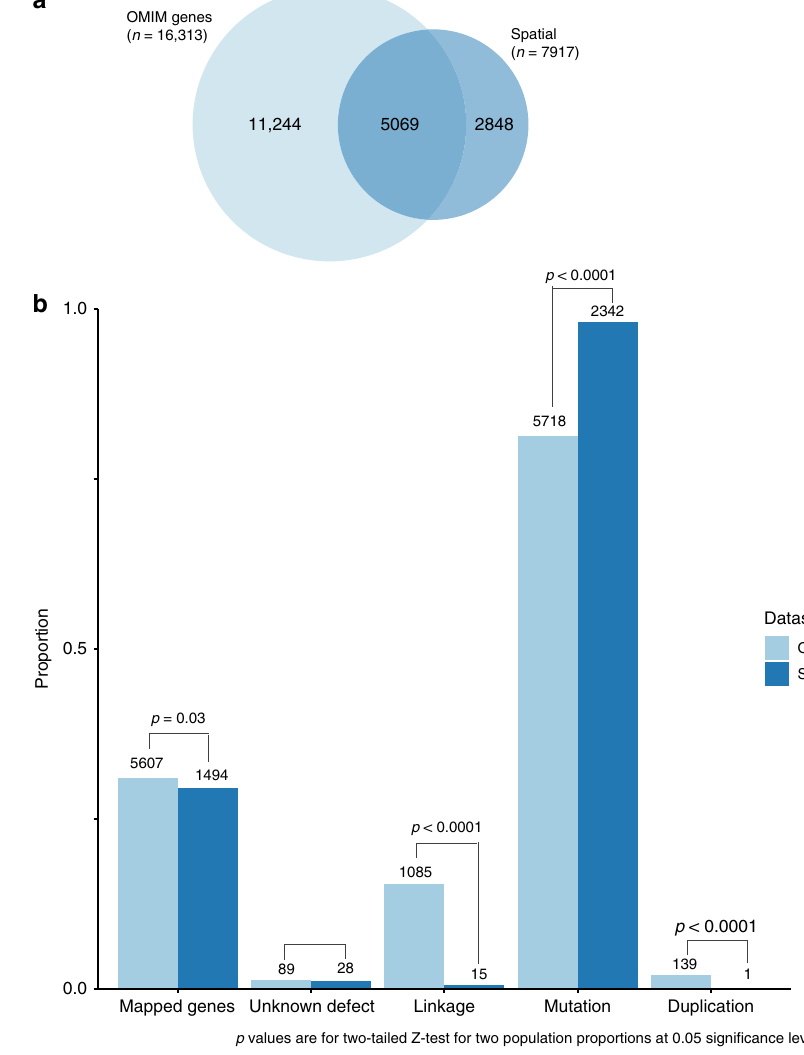
Fig. 6 OMIM analysis of spatial eQTL-eGene interactions. a A total of 62% of the spatial eGenes we identi fi ed are associated with human disease in the OMIM database (retrieved, 11/08/2017, Supplementary Data 6). b A total of 98.2% of gene-phenotype associations of the identi fi ed spatial eGenes are based on known mutations in the genes. OMIM mapping methods are: (1) gene has unknown underlying defect but is associated with the disorder; (2) disorder is mapped to gene based on linkage but mutation in gene has not been found; (3) a mutation in the gene has been identi fi ed as the basis of the mapped disorder; and (4) disorder is caused by deletion or duplication of contiguous genes. Mapped gene proportions were calculated as the number of genes mapped to at least one phenotype in the OMIM data (annotated in graph) divided by the total number of genes in the OMIM data (16,313 for OMIM genes) or the number of spatial eGenes annotated in the OMIM data (5069 for